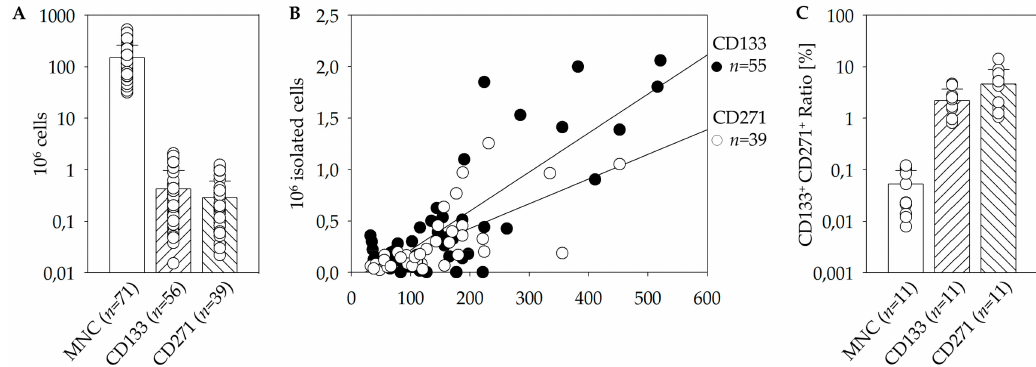
Figure 1. Quality of the immunomagnetic cell separation of CD271 + and CD133 + cells from fresh bone marrow (BM). Mean cell numbers of mononuclear cells (MNC), CD133 + , and CD271 + cells achieved by magnet activated cell sorting (MACS) direct cell isolation ( A ). Linear dependence of CD133 + as well as CD271 + cell numbers on the initial amount of MNC (linear regression plots: R CD133 = 0.821; R CD271 = 0.689; B ). The percentage of the CD133 / CD271 double-positive cells determined within the di ff erent populations MNC, CD133 + , as well as CD271 + cells using flow cytometry ( C